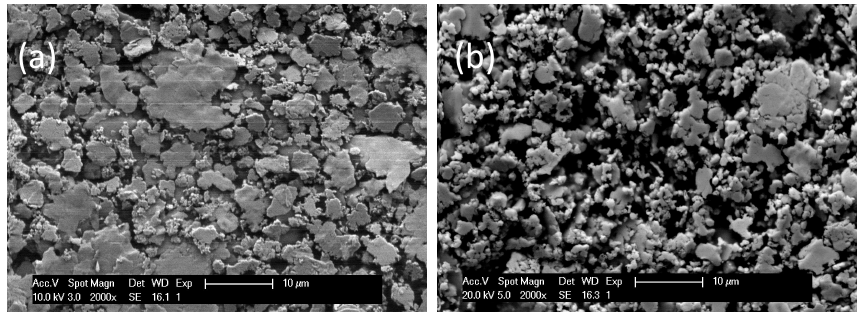
Figure 6. SEM image of the conductive silver epoxy Epotek H20E ( a ) and Circuit Work CW2400 ( b